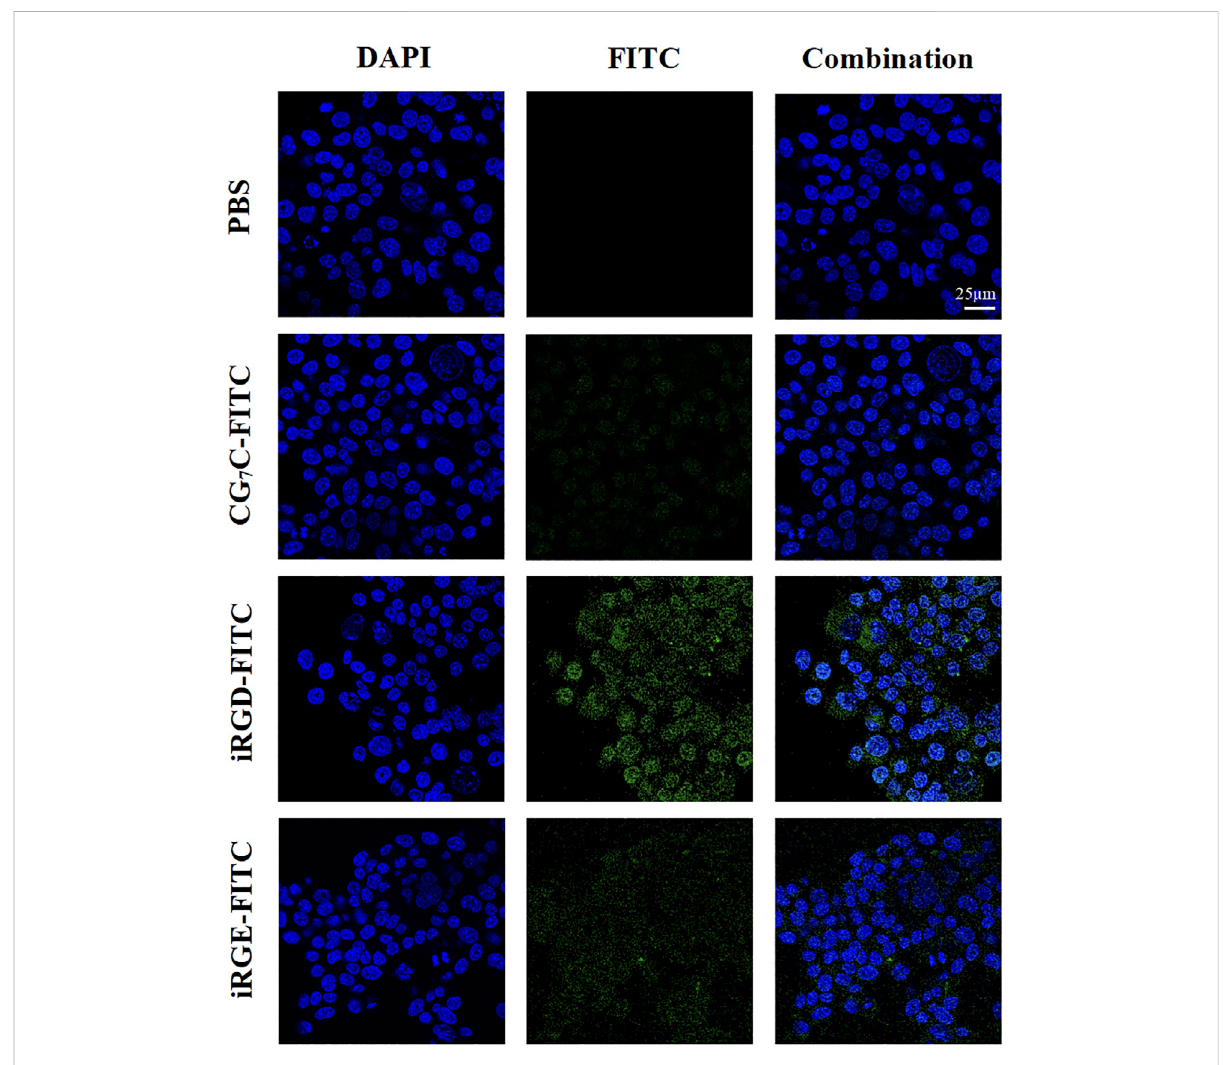
FIGURE 3 Confocal microscopy images of 4T1 cells incubated with CG 7 C-FITC, iRGD-FITC, or iRGE-FITC at a concentration of 10 μ M for 4 h. The scale bar represents 25 μ m for all